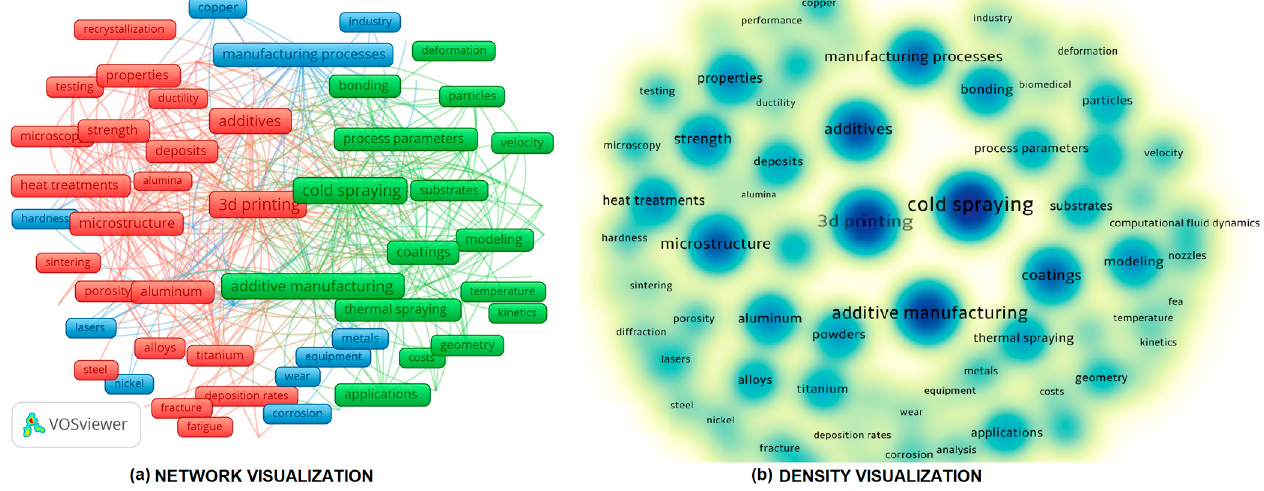
Figure 19. Co-occurrences keywords. Minimum 15 occurrences.